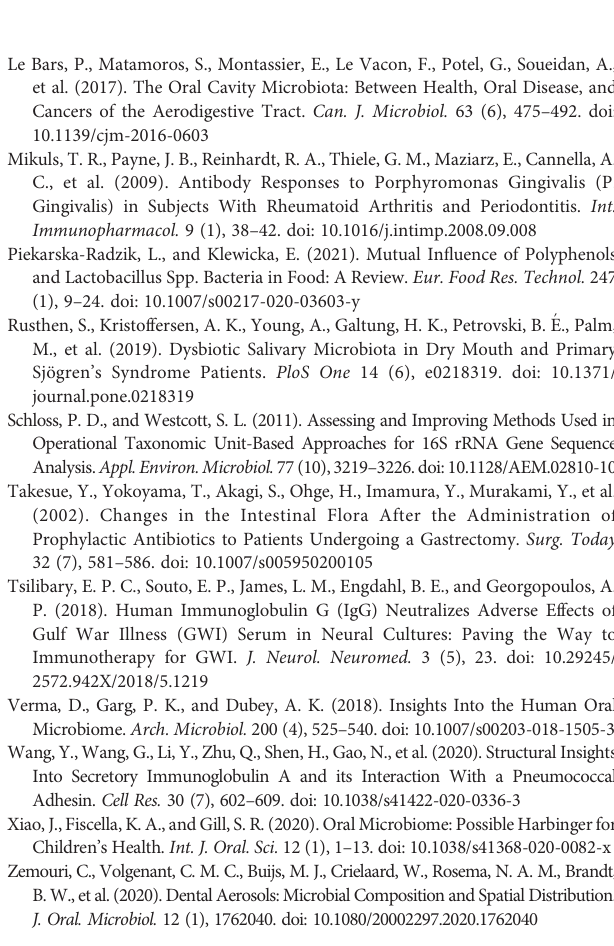
Supplementary Figure 1 | sobs index on OTU level. Supplementary Figure 2 | shannon index on OTU level. Supplementary Figure 3 | numbers of total OTU. Supplementary Figure 4 | Community analysis pieplot on OTU level. Supplementary Figure 5 | Stackedcolumnplotsrepresentingcomparisonofrelative abundanceofbacterialtaxa betweenallgroupsatclass, order, family, andspecies. Supplementary Figure 6 | Correlationsbetweenbacteriaandcorrespondingroups.